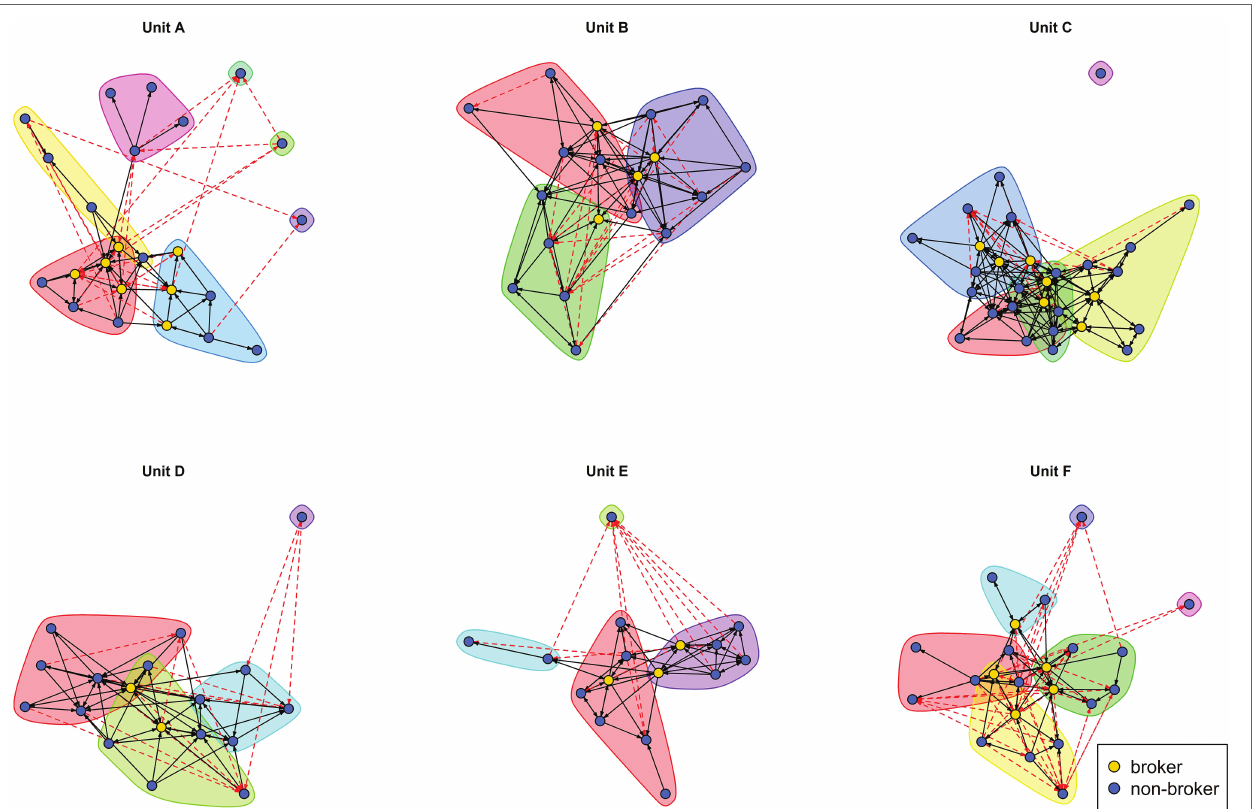
FIGURE 1 | Visual representation of the informal groups and brokers in every unit. Solid black arrows represent positive ties. Dashed red arrows represent negative ties. Colored areas in the background capture different informal groups. Individuals with a broker status are colored in yellow, non-brokers in